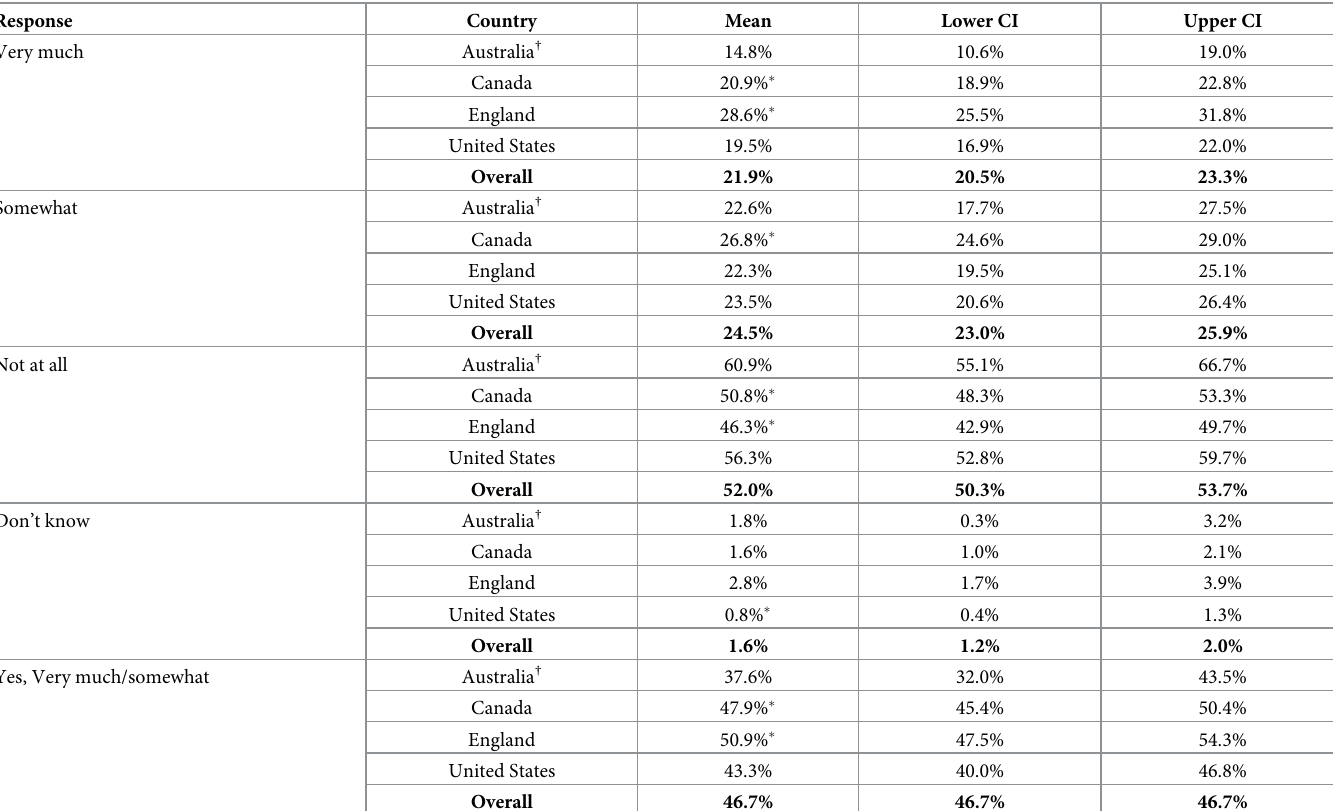
Table 2. Thoughts about quitting smoking because of COVID-19